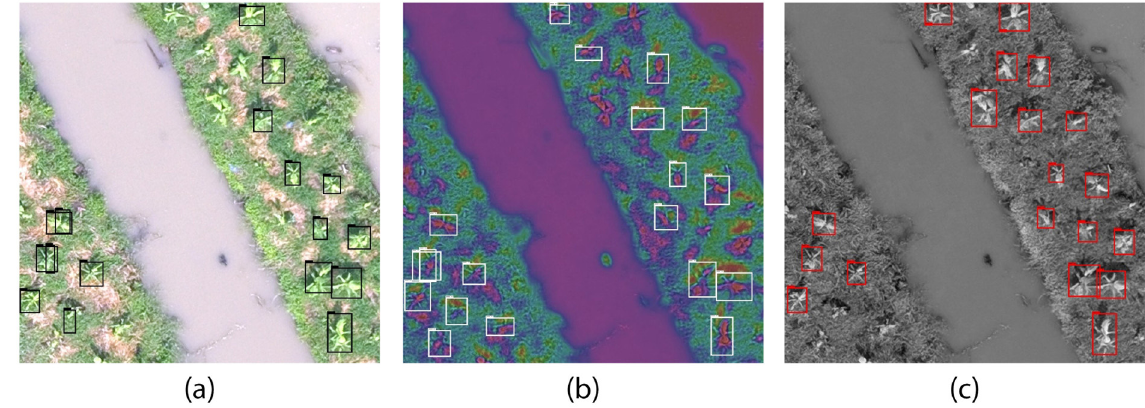
Fig 6. Detection results on variants of image processing methods on a ROI tile of 40m. (a) LCS ( p 1 ), (b) SCT ( p 2 ) and (c) TGI ( p 3 ).